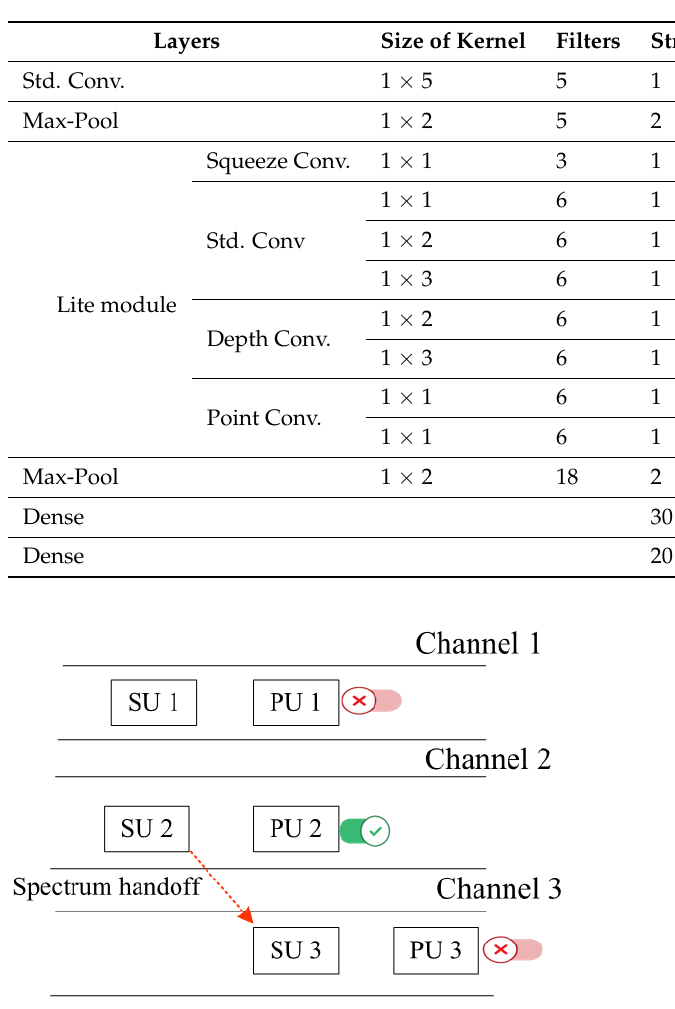
Figure 4. Spectrum